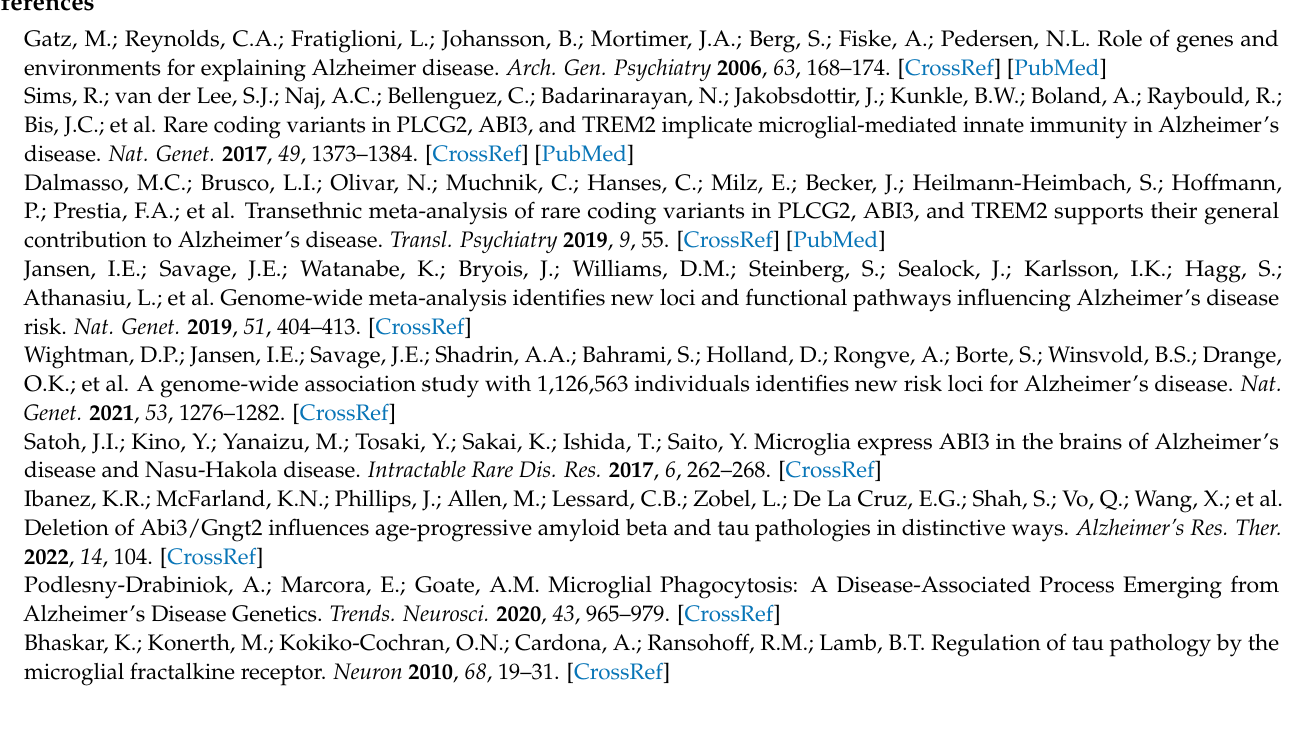
Table S1: Subject metadata for samples used in this